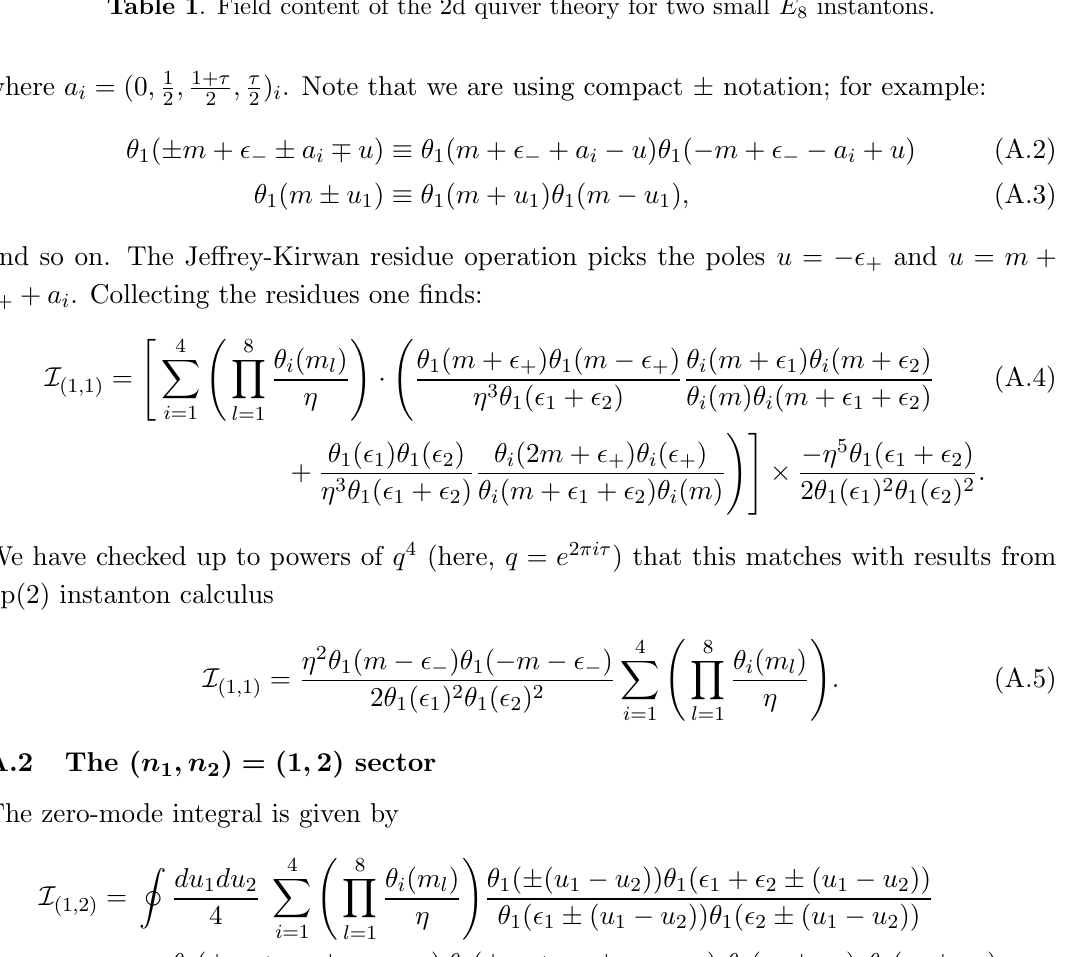
Table 1 . Field content of the 2d quiver theory for two small E